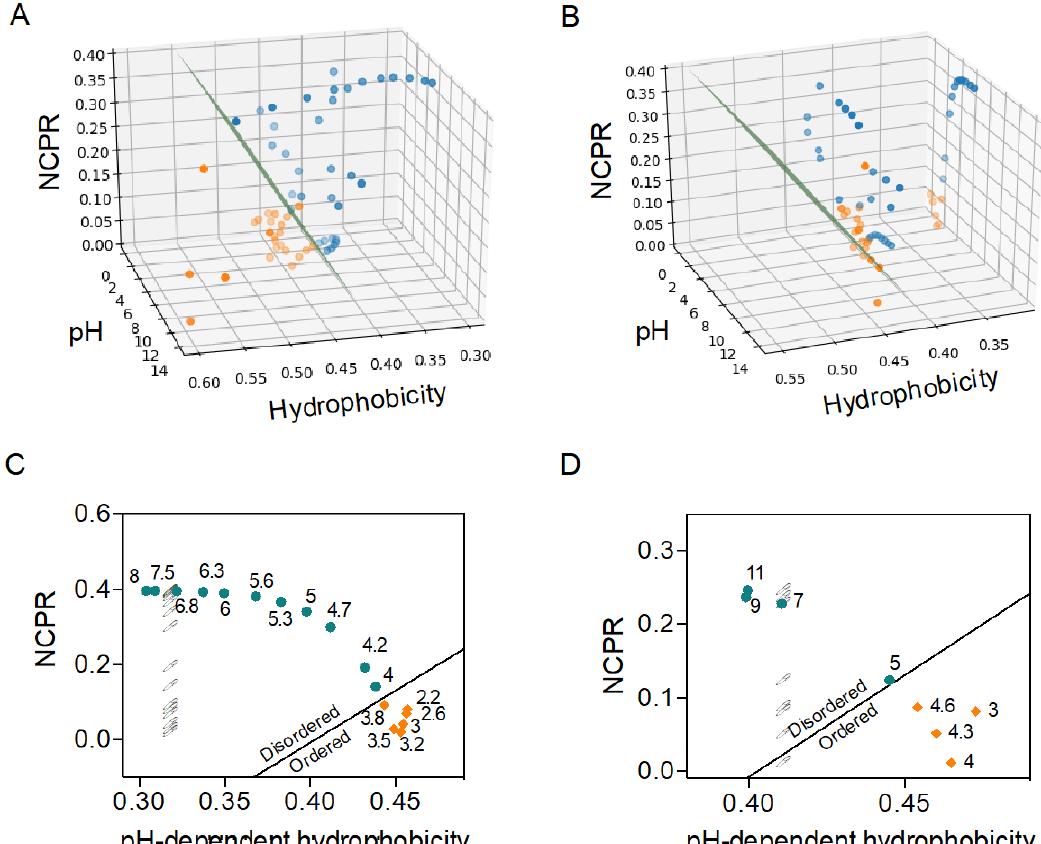
Figure 2. Charge–Hydropathy-based analysis of pH modulated order–disorder transitions. Three- dimensional C–H plots containing 59 datapoints of 7 proteins at different pHs, computing pH influence over ( A ) sequence net charge per residue (NCPR) and hydrophobicity, or ( B ) assuming constant hydrophobicity values (as calculated at pH 7.0). Blue and orange points correspond to conditions in which protein/peptides are disordered and folded, respectively. The green surfaces delimit the boundary conditions between folded and disordered proteins defined by Equation (1). ( C , D ) Two-dimensional C–H plots of ( C ) prothymosin and ( D ) PEST-c-myc using the same color pattern than in panels A and B for folded-unfolded datapoints. A solid line represents the boundary condition. Open circles represent the same data points assuming constant hydrophobicity values (as calculated at pH 7.0).